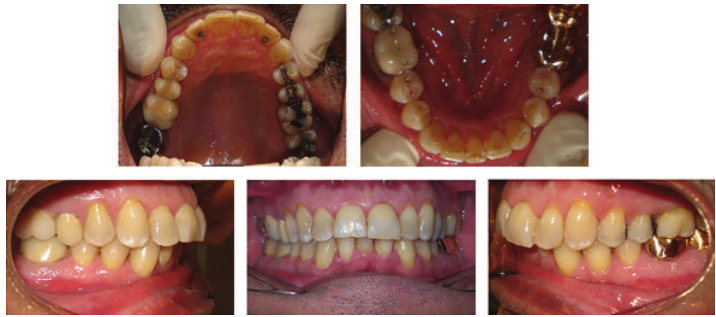
Figure 4: Posttreatment intraoral photographs.